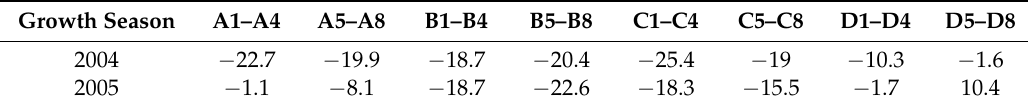
Table 5. Average relative error between simulated and observed summer maize yield